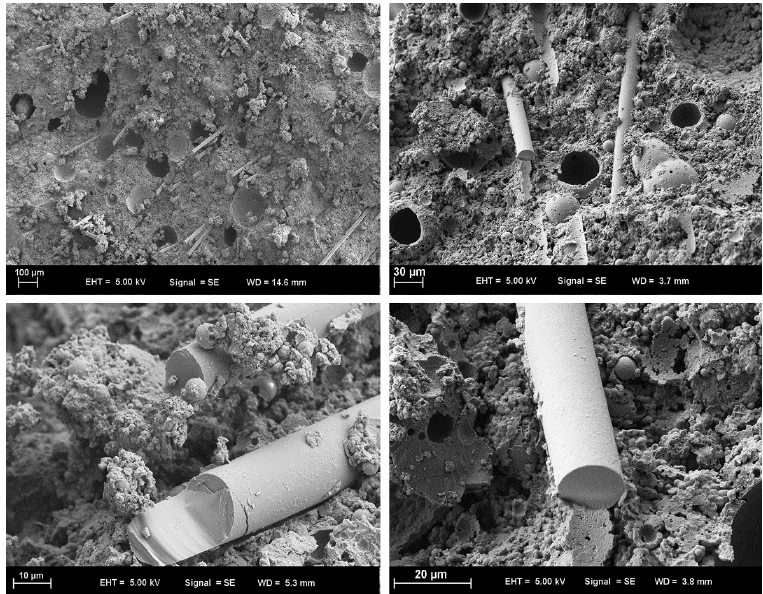
Figure 20. SEM micrographs showing the microstructure of basalt FRGP [113]. (Reprinted with permission from the publisher, Elsevier; License No.